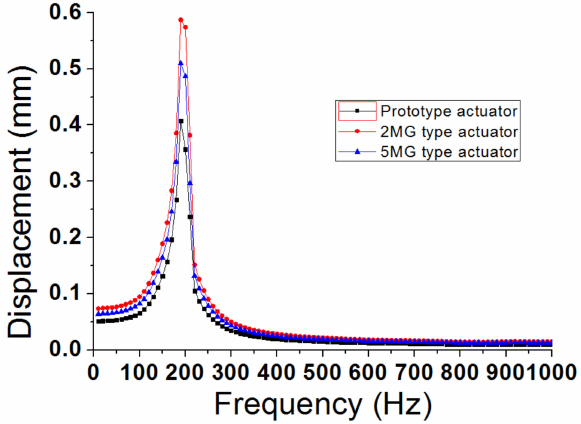
Figure 10. Vibration displacement comparison between three